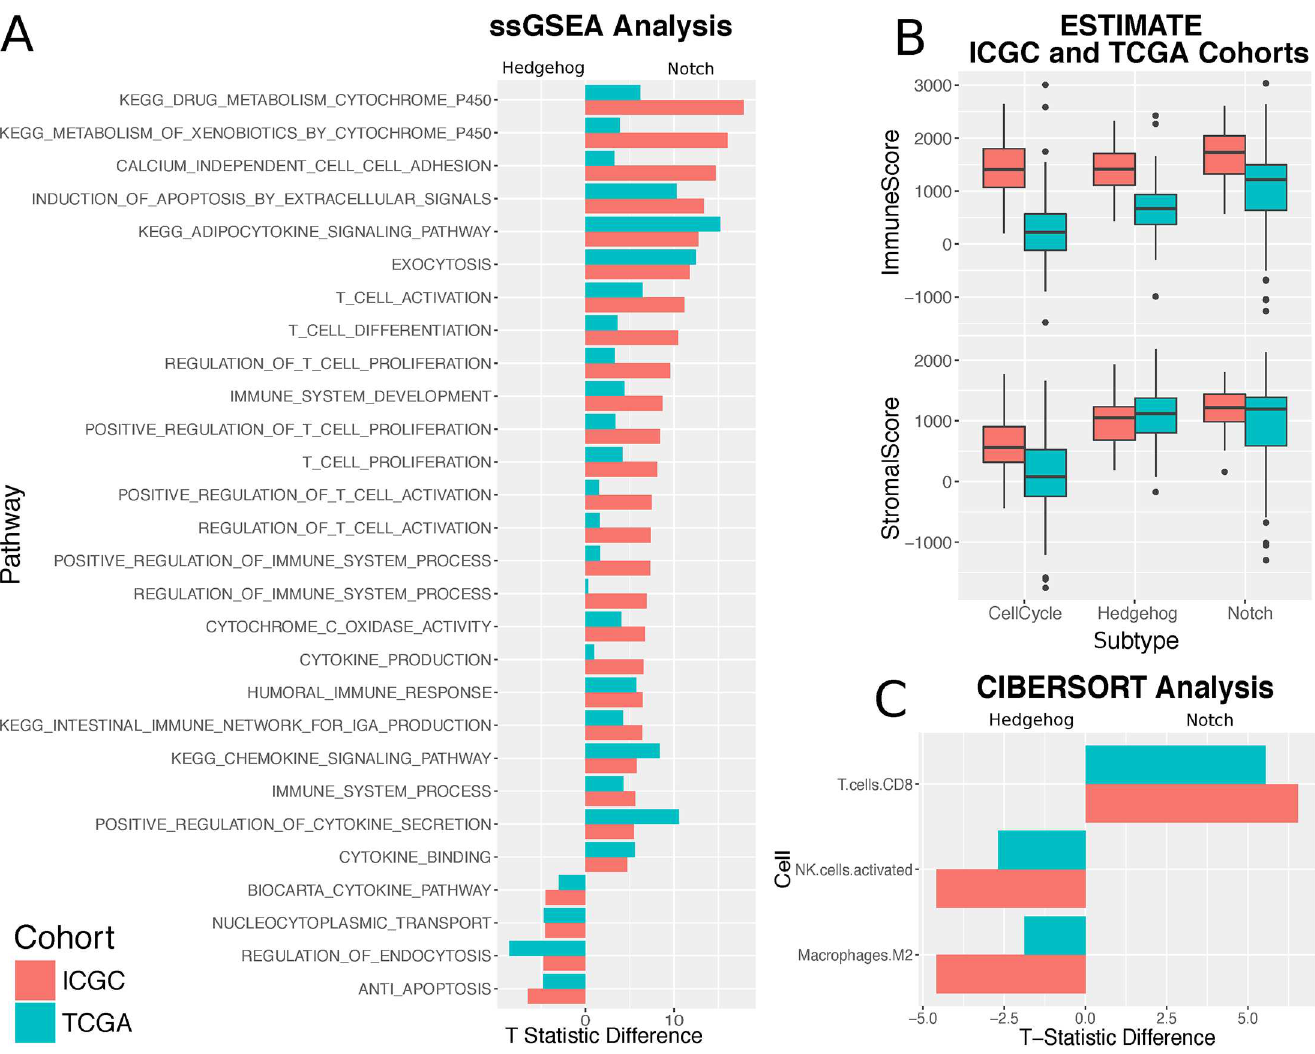
Fig 4. Subtypes show different immune activity. A. Bar plot showingthe Pearson partial correlationt-statistic difference betweenHedgehogand Notch for ssGSEA pathway enrichment scores significantly associatedwith one subtype or the other. B. Boxplots from the ESTIMATE analysisshowingthe variation in the stromal and immune content betweenthe Hedgehog, Notch, and cell cycle subgroups for both the ICGC and TCGA cohorts. C. Bar plot showingthe difference in Pearson partial correlationcoefficient difference betweenHedgehogand Notch for estimated CIBERSORT leukocyte cell fractions significantly associated with one subtype or the other. A negative difference highlightsstrong associationwith Hedgehog, whereasa positive value indicatesa strong associationwith Notch.